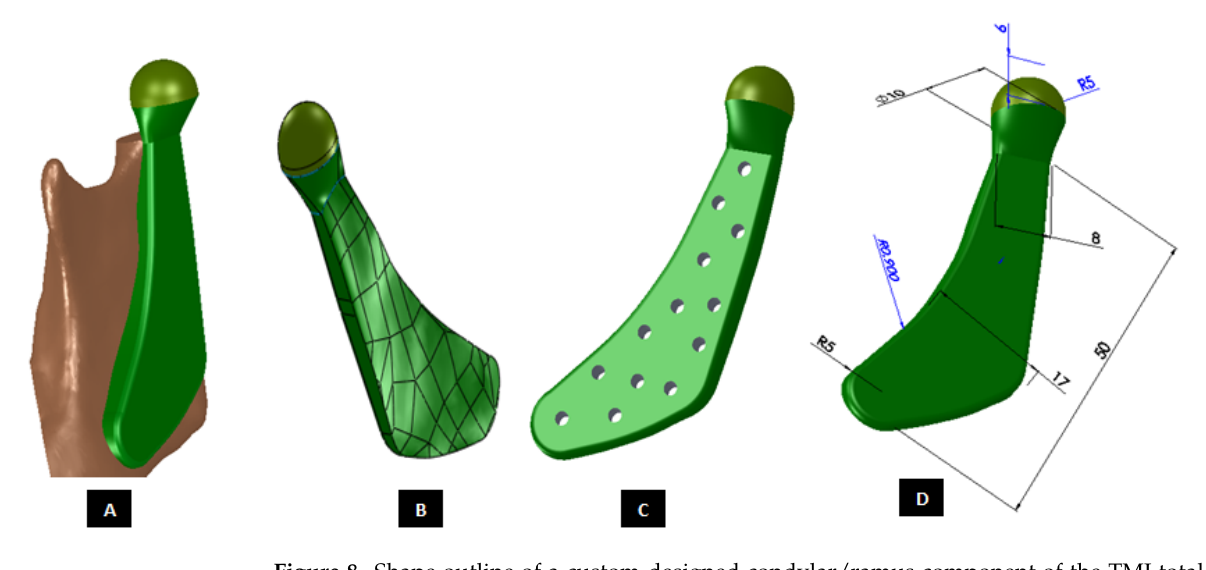
Figure 8. Shape outline of a custom-designed condylar/ramus component of the TMJ total joint replacement prosthesis for left TMJ of a patient. ( A ) Shows anterior–lateral view of the implant with host bone after condylectomy. The posterior–medial view in ( B ) shows that the medial surface of prosthesis is shaped to accurately follow geometric contours of the lateral surface of mandibular host bone for optimal geometrical match between the implant and host bone. ( C ) Shows lateral view of the prosthesis with screw holes. Dimensions of various parts of this patient-specific implant are shown in ( D ).